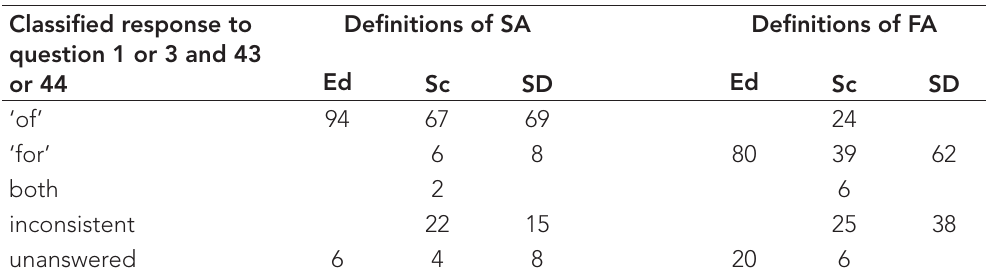
Table 4: The consistency of classified responses to the repeated questions asking for definitions of SA (questions 1 and 43) and FA (questions 3 and 44)